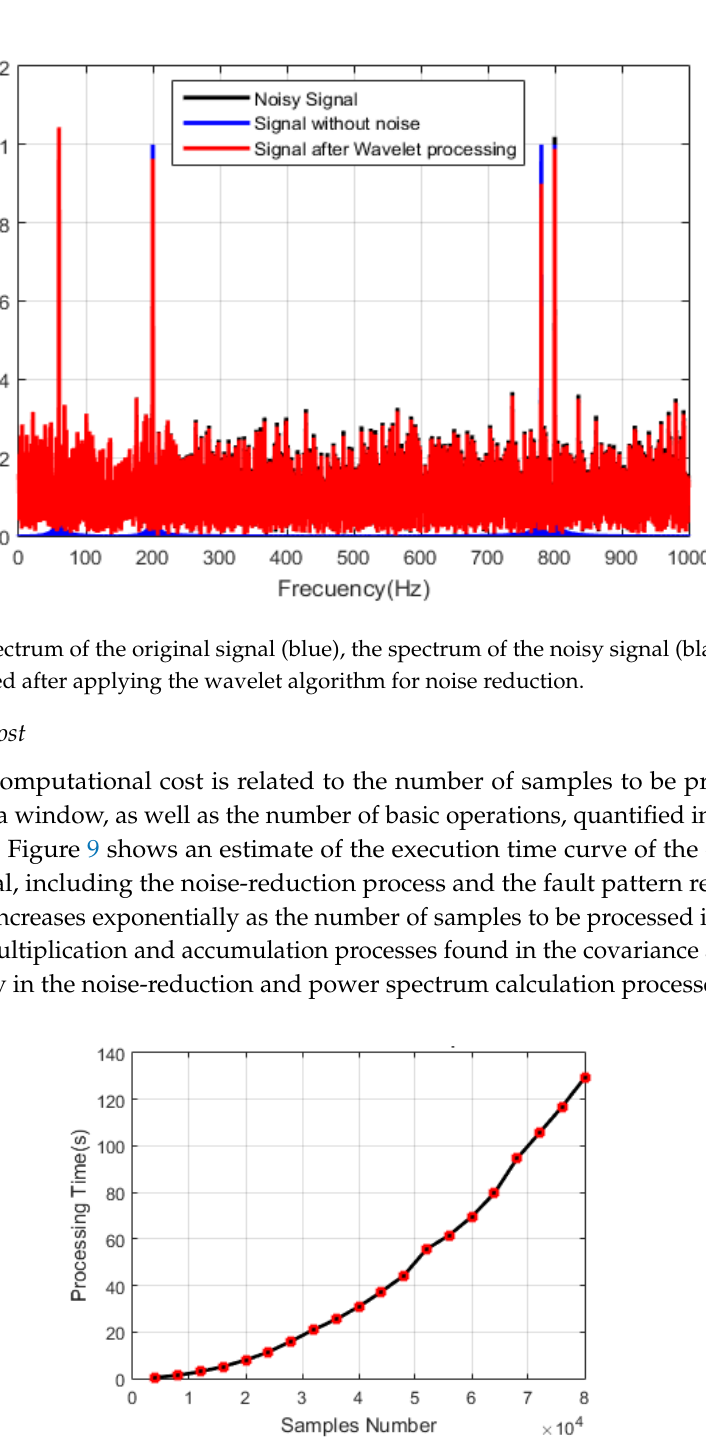
Figure 10. T-bench of the tested rotors. The processed signals of a rotor with 28 bars present the following characteristics: (1) healthy, (2) one broken bar, two broken bars in the relative positions 1 and 2, (3) two broken bars in the relative positions 1 and 3, and (4) two broken bars in the relative positions 1 and 5. See Figure 10 for the T- bench of the tested rotors. In each test, we recorded the acoustic noise signal with a conventional smartphone equipped with an internal microphone (type omnidirectional condenser) that enabled us to capture the required signals at a sampling rate of 16 kHz. The sampling window consists of 80,000 data measurements. The sampling window consists of 80,000 data measurements. To prevent any vibration influence in the recording, we have located the microphone was at the same place in all the